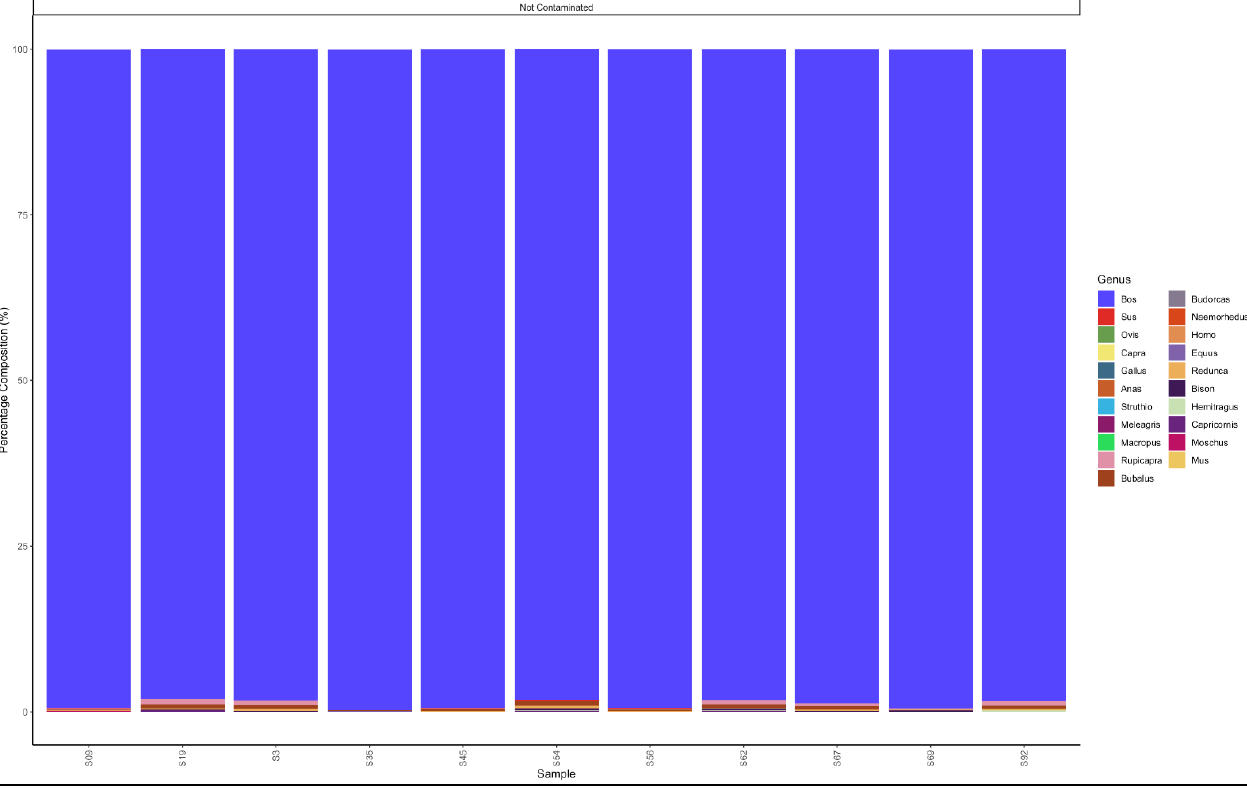
Figure 4. Percentage composition of biltong samples not specified which species they are from. The pipeline also demonstrated that 14 out of the 17 samples labelled as beef biltong were uncontaminated and were also essentially from beef ( Bos genus) (Figure 5). The con- taminated samples, descending from most contaminated, were predominantly composed as follows: Sample 16: Bos (cattle) (57.5) and Sus (pig) (37.4); Sample S: Bos (cattle) (93.6) and Ovis (sheep) (4.9); and Sample 117: Bos (cattle) (97.9) and Bubalus (Buffalo) (0.7). The major contaminants of the labelled beef biltong products were pork ( Sus ) and mutton ( Ovis ). Sample 16 contained beef ( Bos ) (57.5) but was contaminated with pork ( Sus ) (37.4) and mutton ( Ovis ) (4.6) (Table